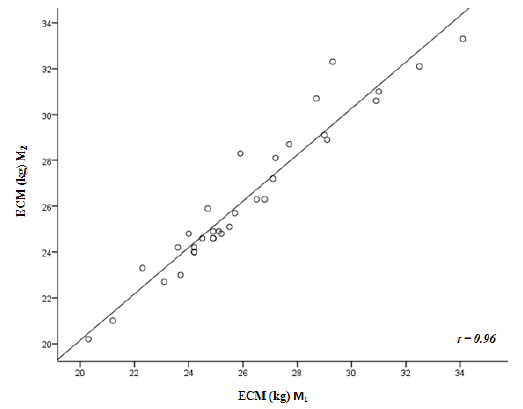
Figure 10. Correlation between the values of param- eters measured by Nutriguard-M before and after the intake of fluids – extracellular mass (kg)